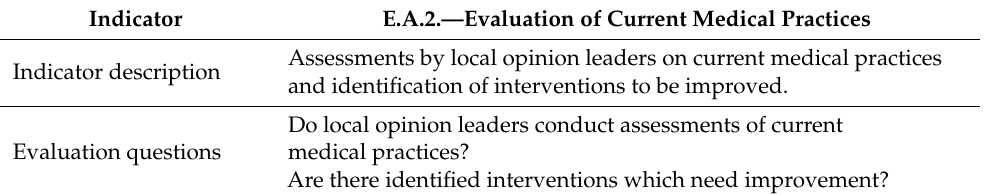
Table 13. The indicator E.A.2.—Evaluation of current medical practices.